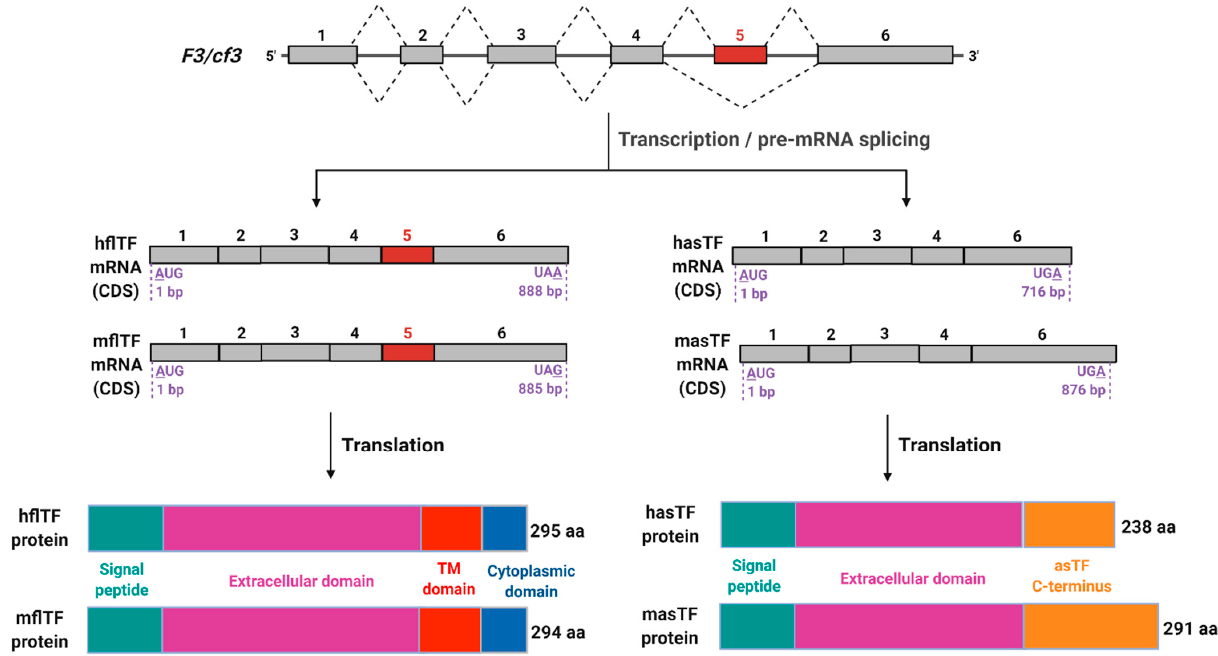
Figure 1. Schematic representation of F3 / cf3 pre-mRNA splicing products. Top to bottom: In mouse and human, F3 and cf3 genes, respectively, encode six exons that contribute to open reading frames; five introns are removed during pre-mRNA processing. Two mature mRNA products are produced (coding sequences (CDS) are shown) in both mouse and human; of note is the extended 3 (cid:48) end of murine asTF (masTF) compared to human asTF (hasTF), which is a result of a frameshift in the coding region due to the exclusion of exon 5 during alternative splicing. Human and murine flTF proteins are of nearly identical lengths with high sequence similarity, while there is a greater variation between hasTF and masTF proteins, with the latter containing an additional 54 amino acids in its C-terminus. This figure was adapted from Bogdanov et al. (2006) and Bogdanov (2007) [11,12]. Image created with BioRender.com (Accessed on 9/13/21).